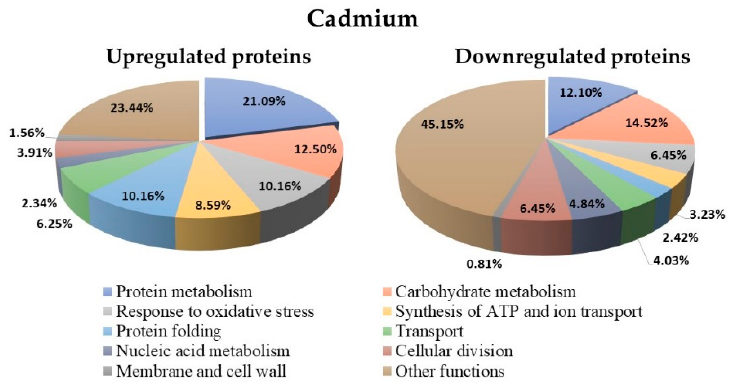
Figure 8. Biological function classification of the 252 differentially regulated proteins under Cd 2+ ion treatment in Y. lipolytica AMJ6. The predominant proteins in both the up- and downregulated groups were related to protein metabolism.